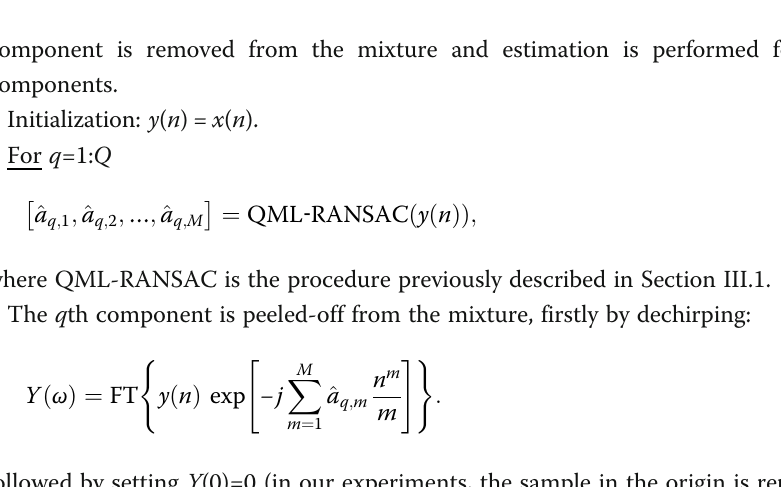
component is removed from the mixture and estimation is performed for weaker components.